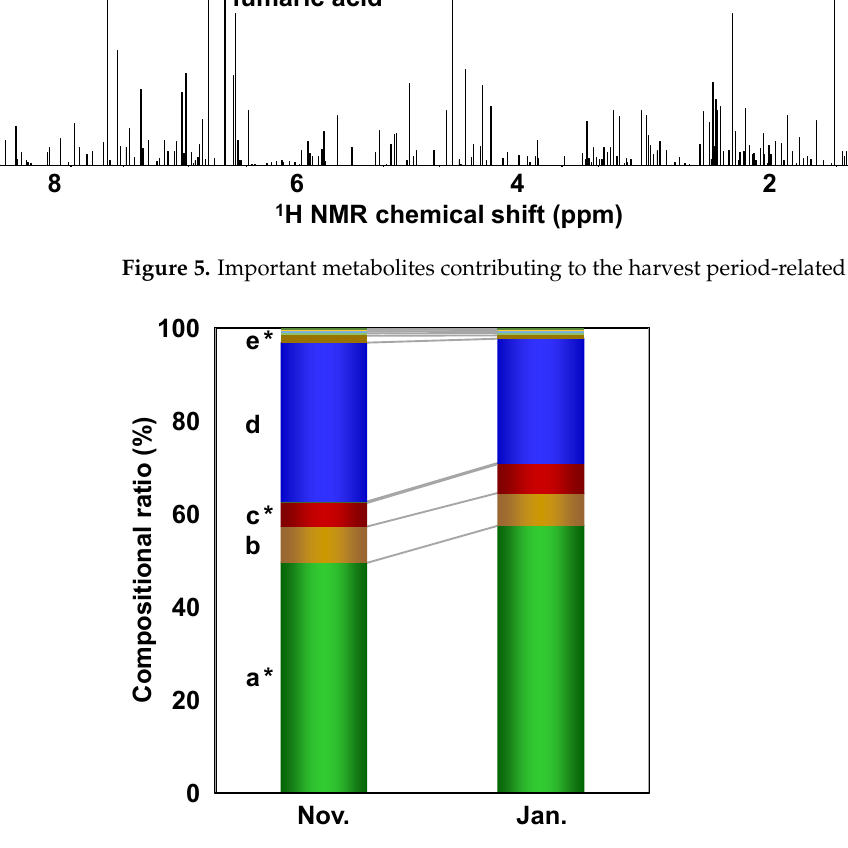
Figure 6. Compositional ratios of top 10 metabolites identified by the analysis of importance. a, trans -aconitic acid; b, threonine; c, unannotated metabolite; d, alanine; e, galactose; *, p < 0.01.